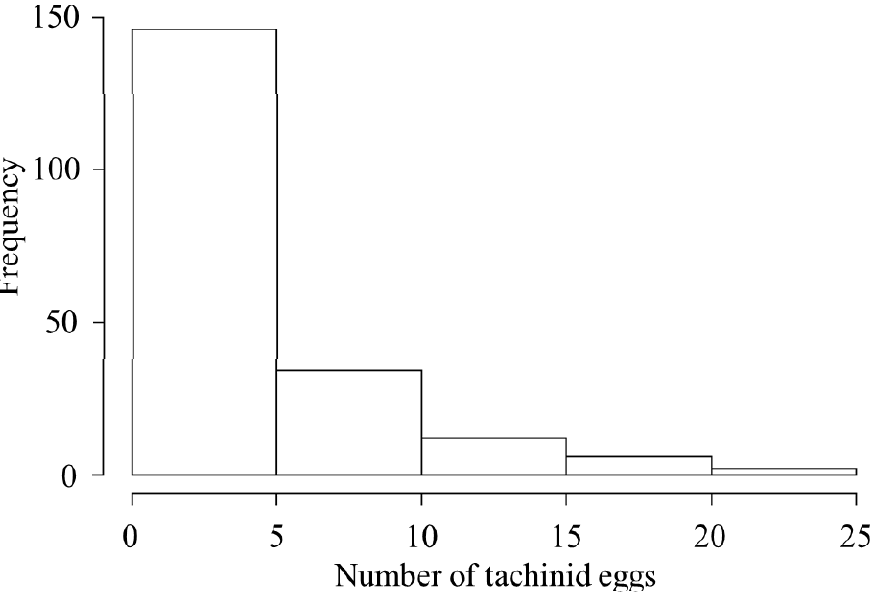
Figure 2. Histogram of visible tachinid eggs per host. Table 1. Means, standard errors and ranges of CEW caterpillar body mass and tachinid egg